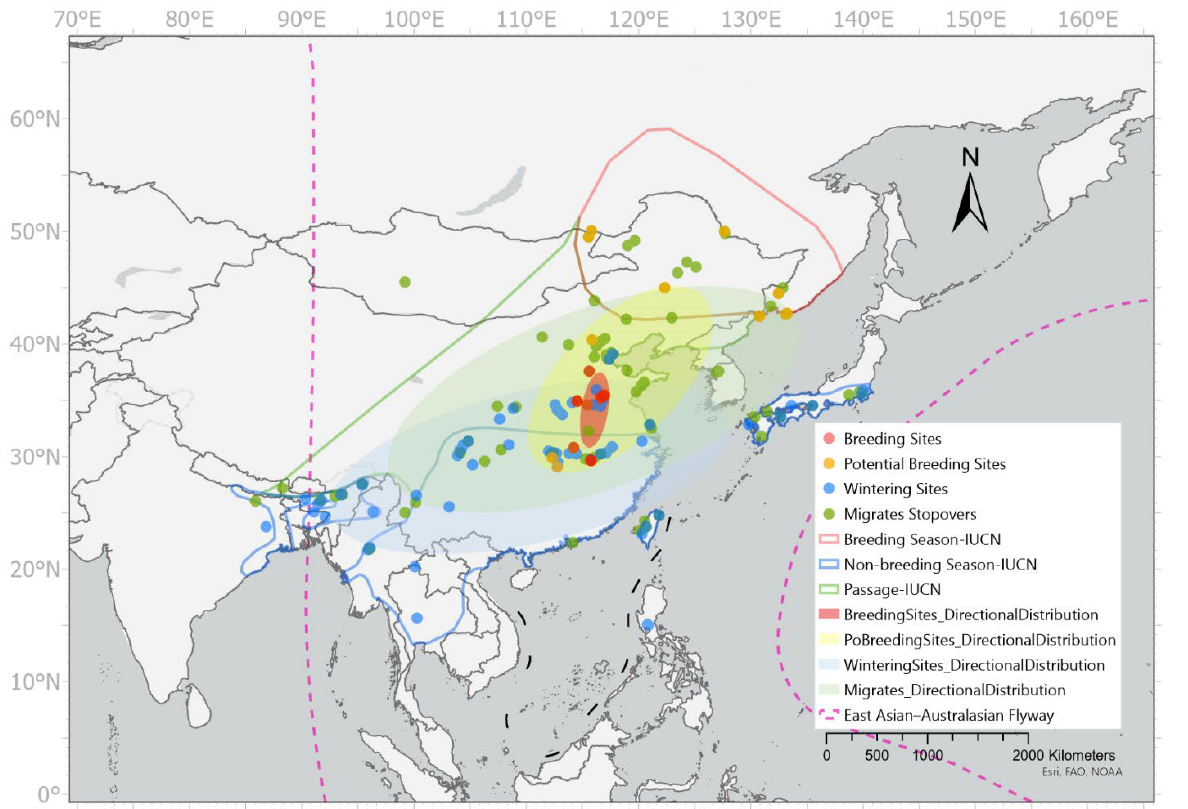
Figure 3. The central breeding range of Baer’s Pochard has shifted to central-east China, and the wintering ground has expanded northward in comparison with the current distribution map by IUCN. In addition, there is a large geographical overlap among the three life stages (breeding, stopover and wintering).